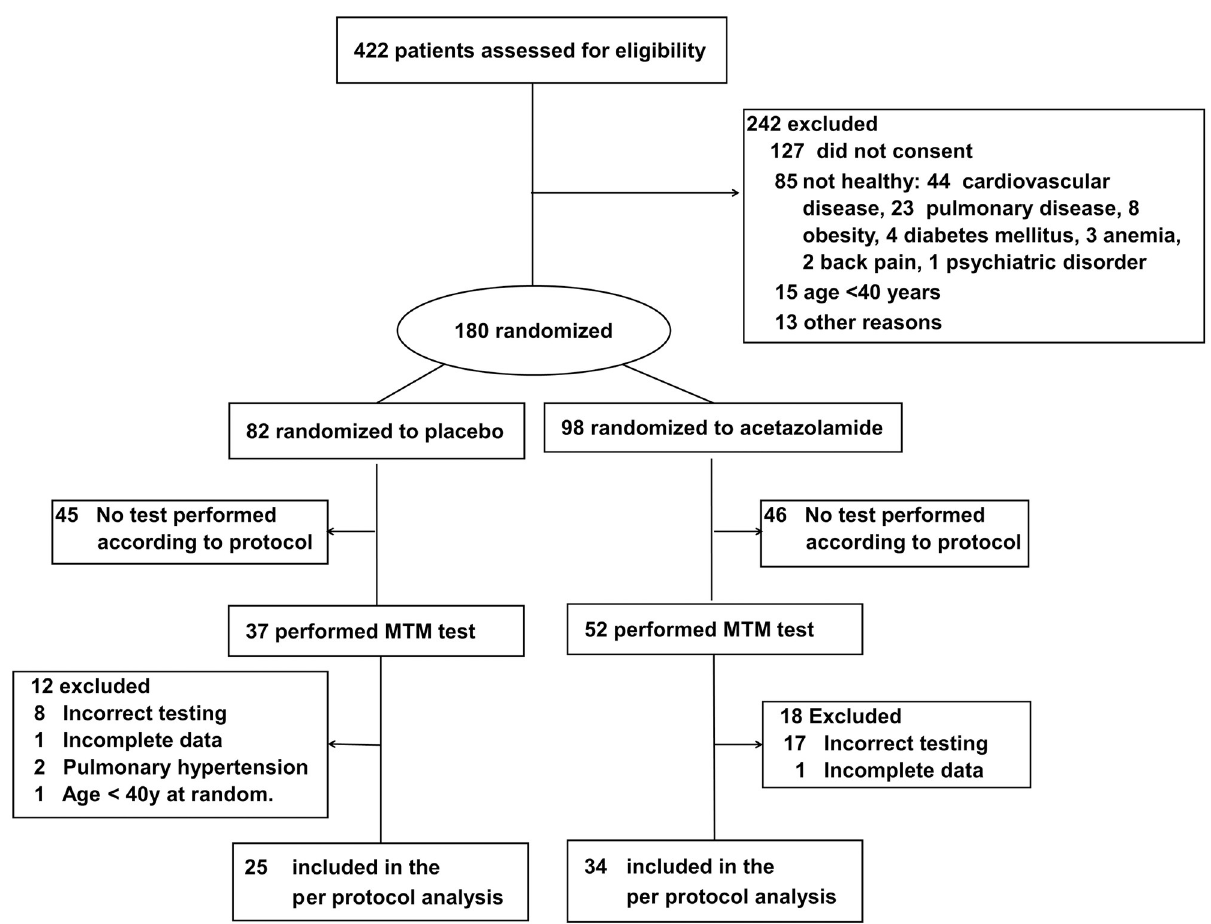
Fig 2. Participant flow chart. BMI = body mass index; COPD = chronic obstructive pulmonary disease; MTM = motor task manager; random. = randomization; y. = years.